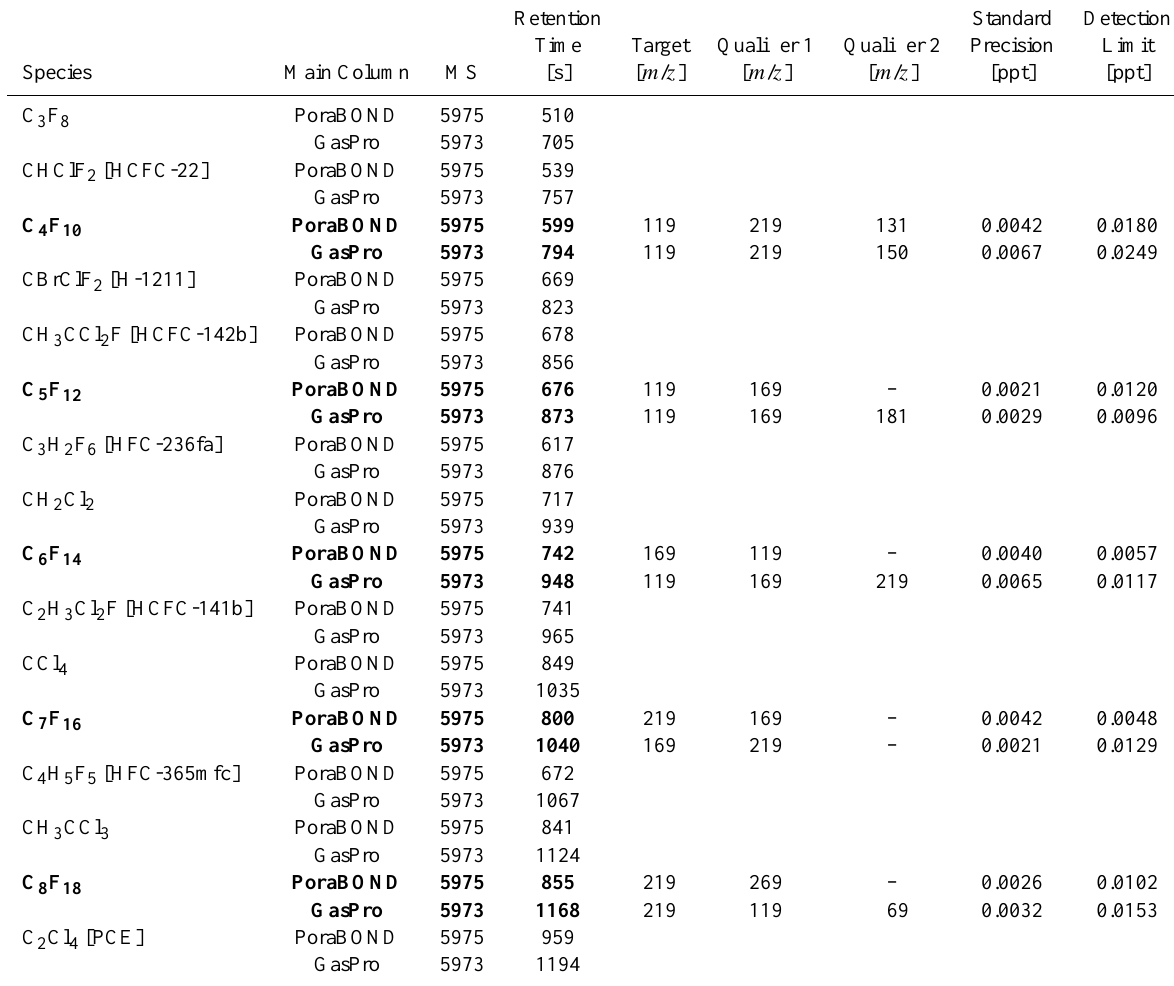
Table 2. Retention Times, Target and Qualifier Mass-to-Charge Ratios, Standard Precisions and Detection Limits for C 4 F 10 , C 5 F 12 , C 6 F 14 , C 7 F 16 and C 8 F 18 .